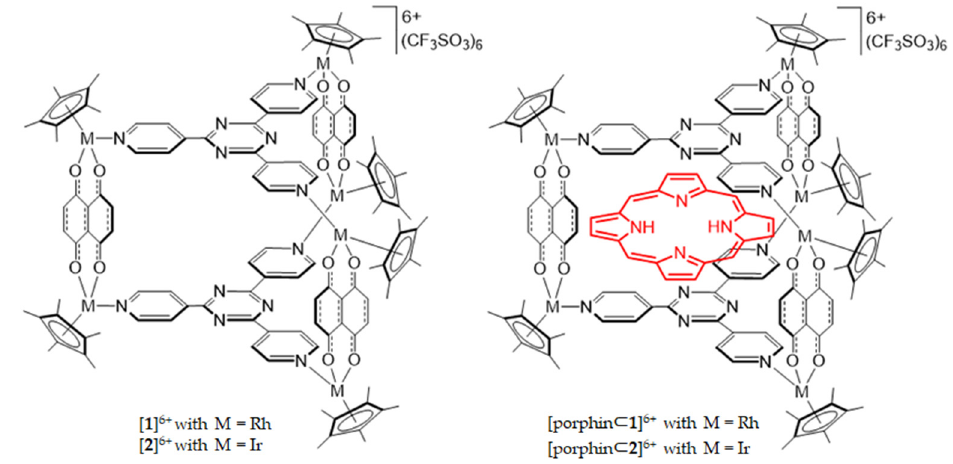
Figure 8. Molecular structures of [ 1 ] 6+ ,[ 2 ] 6+ , [porphin ⊂ 1 ] 6+ and [porphin ⊂ 2 ] 6+